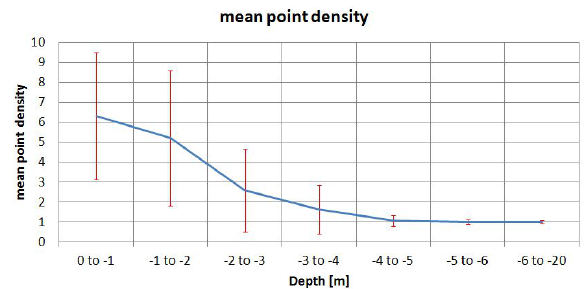
Figure 10: Mean point density of sea bed points per depth level (Area 4).